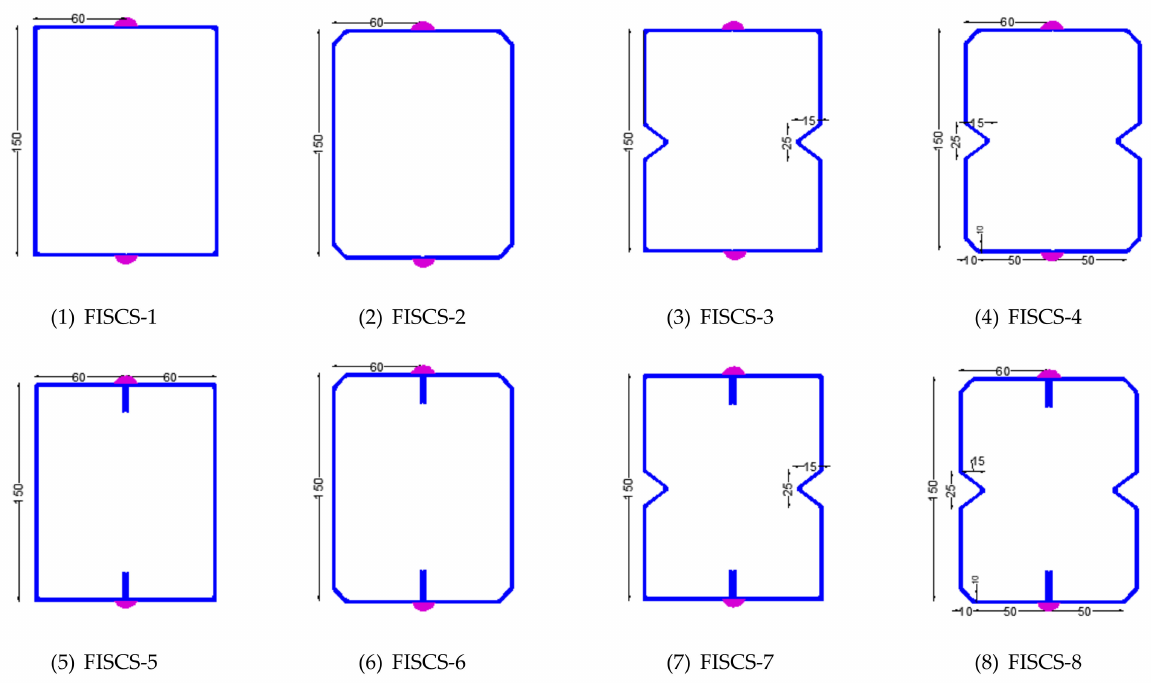
Figure 18. Face-to-face intermediate channel sections considered for the parametric study. (All the dimensions are in